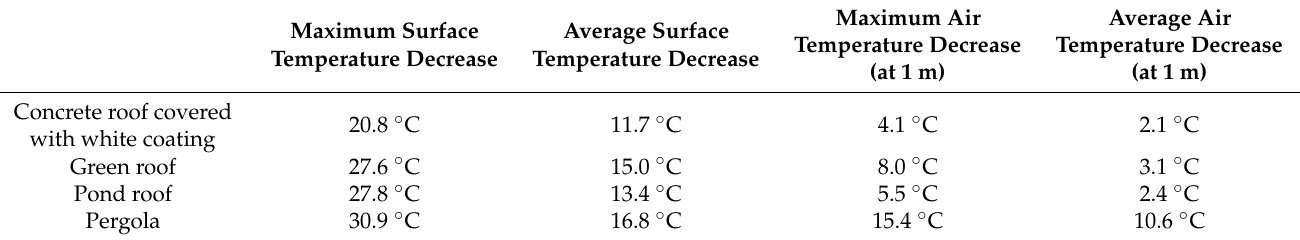
Table 3. Performance of the four roofs in the hot and humid climate (Mumbai)